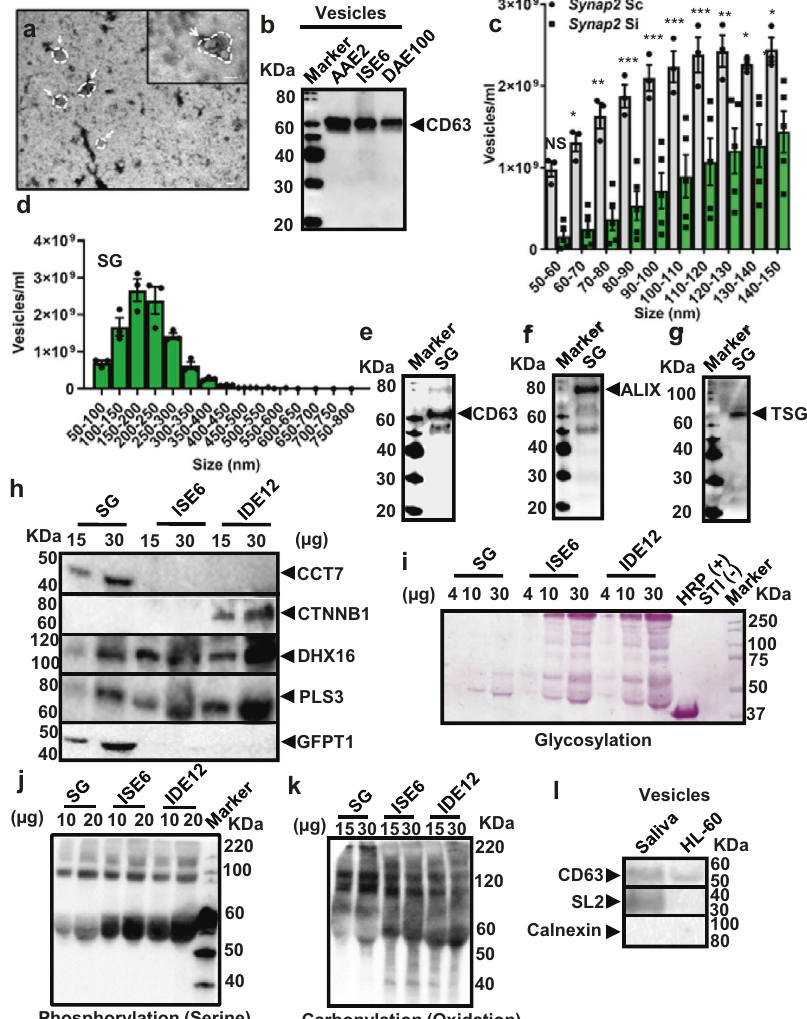
Fig. 1 Ticks secrete EVs with a distinct cargo pro fi le. a Transmission electron microscopy of EVs released by I. scapularis (ISE6) cells. Scale bar: 100 nm, large panel = 11,000x; small panel = 30,000x. The image is representative of two independent experiments. b SDS-PAGE immunoblot showing CD63 + EVs puri fi ed from AAE2, ISE6, and DAE100 tick cells (70 µ g of protein). Images are a representation of three independent experiments. c I. scapularis ISE6 cells transfected with synaptobrevin 2 small interfering ( Synaptobrevin 2 si ) (green) or scrambled control RNA ( Synaptobrevin 2 sc ) (gray) to reduce the EV release. Concentration and size distribution of EVs were measured by nanoparticle tracking analysis (NTA). Mean± standard error of the mean (SEM) of technical replicates plotted from one of two independent experiments are shown. Similar results were obtained in both independent studies. Two-way ANOVA using size and treatment as variables followed by Sidak ’ s multiple comparison statistical test of the same size vesicles between treatments. * p < 0.05; ** p < 0.005; ***; p < 0.001; NS not signi fi cant. d EVs originated from I. scapularis salivary gland (SG) cultures. Mean± SEM are plotted. Data is representative of three independent experiments. e – g SDS-PAGE immunoblots showing CD63 + , ALIX + , and TSG101 + EVs puri fi ed from I. scapularis SGs (24 µ g of protein). h CCT7, CTNNB1, DHX16, PLS3, and GFPT1 expression in EVs puri fi ed from partially engorged I. scapularis SG and uninfected tick cells. i Glycosylation of proteins in EVs puri fi ed from partially engorged I. scapularis SG and tick cells. HRP ( + ) represents the horseradish peroxidase positive control and STI ( − ) indicates the soybean trypsin inhibitor negative control for the assay. j , k Phosphorylation and carbonylation of proteins in EVs puri fi ed from partially engorged I. scapularis SG and tick cells. l EVs puri fi ed from I. ricinus saliva and immunoblotted against CD63, Sialostatin L2 (SL2), and calnexin (15 µ g of protein). EVs from HL - 60 were used as control cells, whereas calnexin was used as a technical negative control. Blots are representative of two independent experiments. Source data are provided as a Source Data fi